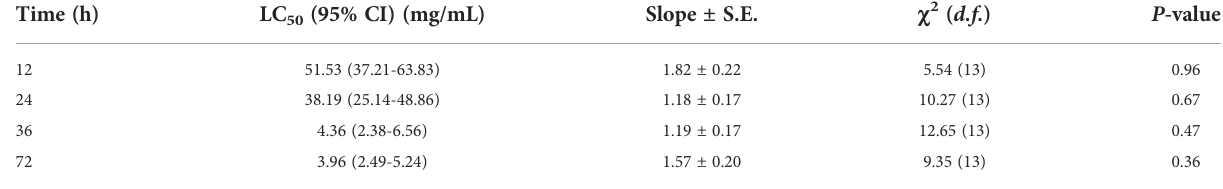
TABLE 1 The residual toxicity of PSO (pomelo seed oil) against Aphis craccivora. Time (h) LC 50 (95% CI) (mg/mL) Slope ±